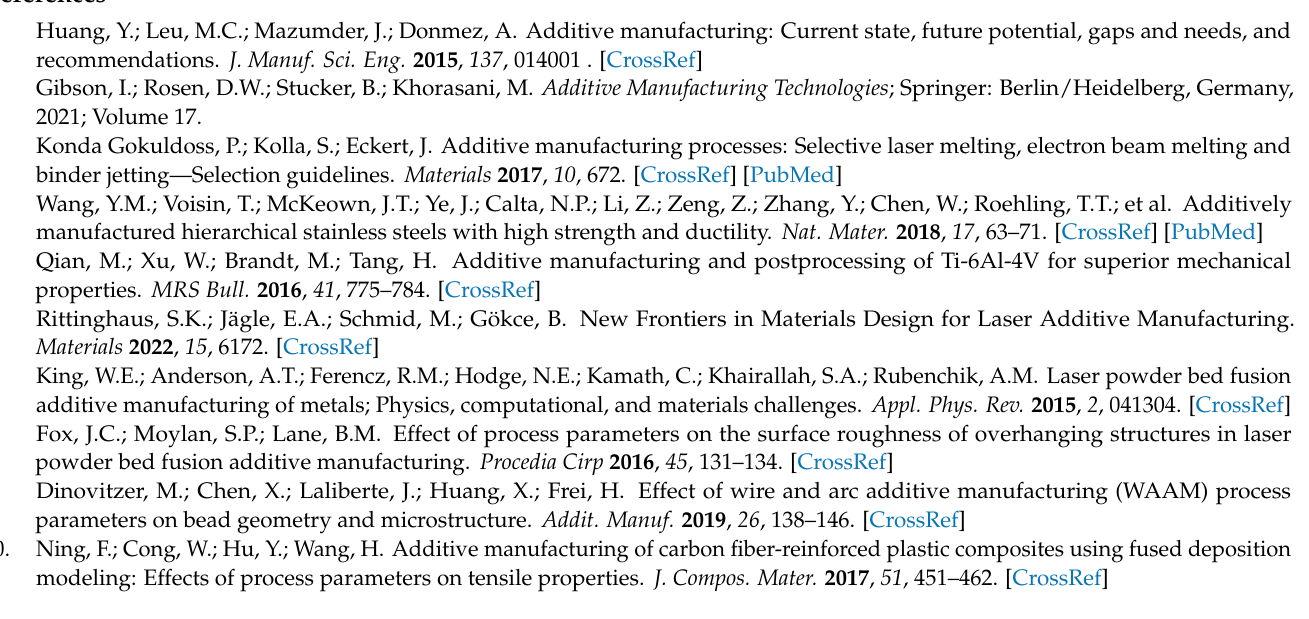
Table S2: Process conditions for alloys. Figure S1: Measure of total advection measured ( Pe ν max ) vs surface tension based advection Ma ˆ U for IN718 and AZ91D. Figure S2: Measure of total advection measured ( Pe ν max ) vs surface tension based advection Ma ˆ U for all materials in a combined plot. Figure S3: Correlation of the aspect ratio with Ma ˆ U for all alloys in a combined plot. Figure S4: Correlation of the meltpool volume with Ste ˆ U for IN718 and AZ91D. Figure S5: Correlation of the T c meltpool volume with Ste ˆ U for all alloys in a combined plot. Figure S6: Dimensionless temperature T c gradient (G) with the ˆ U for IN718 and AZ91D